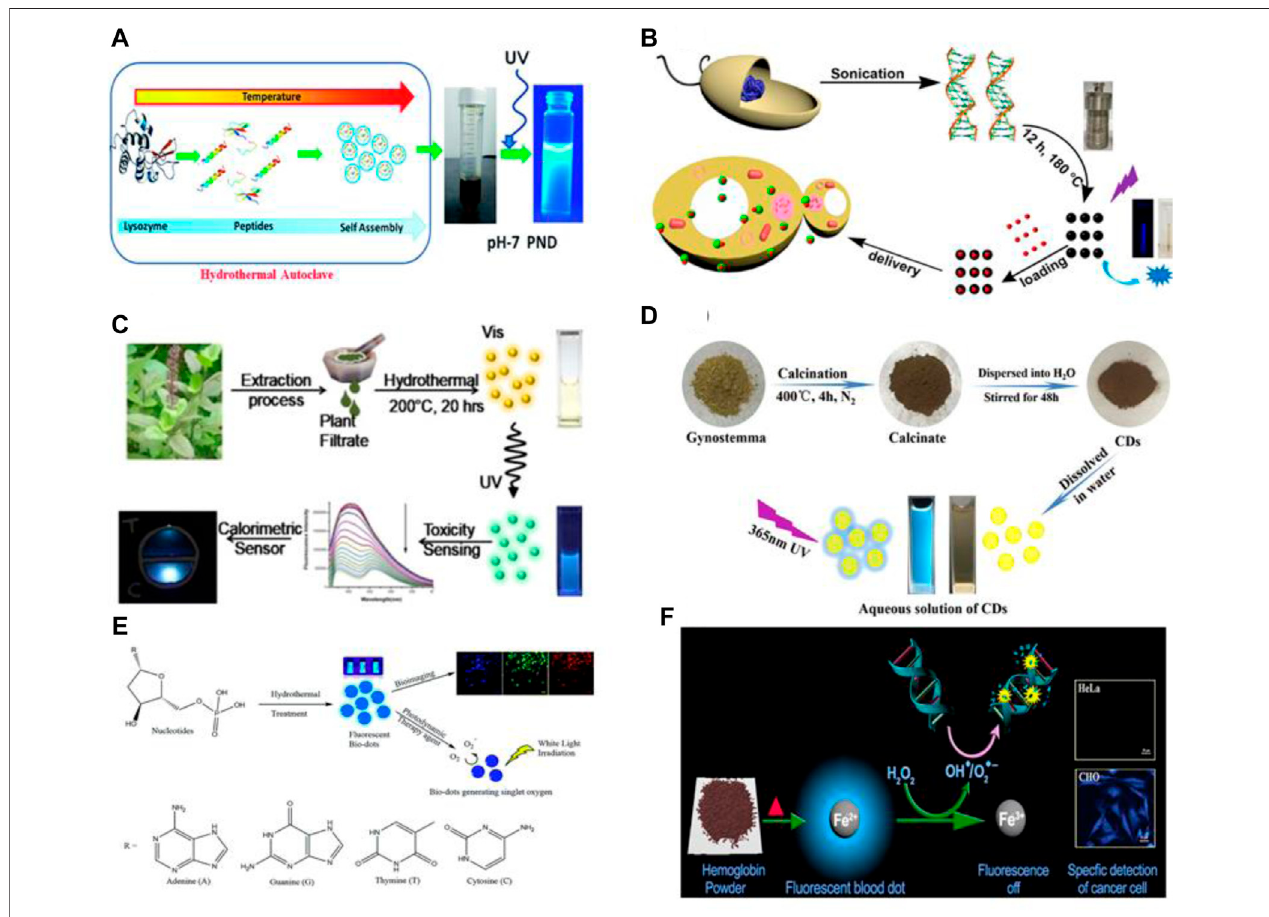
FIGURE 3 | Schematic of Synthesis of CQDs from (A) lysozyme via hydrothermal method(Yadav et al., 2021), (B) DNA via sonication and hydrothermal method (Ding et al., 2015), (C) Ocimumtenui fl orum via hydrothermal method(Shukla et al., 2020), (D) Gynostemma via Calcination (Wei et al., 2019), (E) nucleotides via hydrothermal method (Zheng et al., 2019)and (F) hemoglobin via simple heating (Chakraborty et al.,